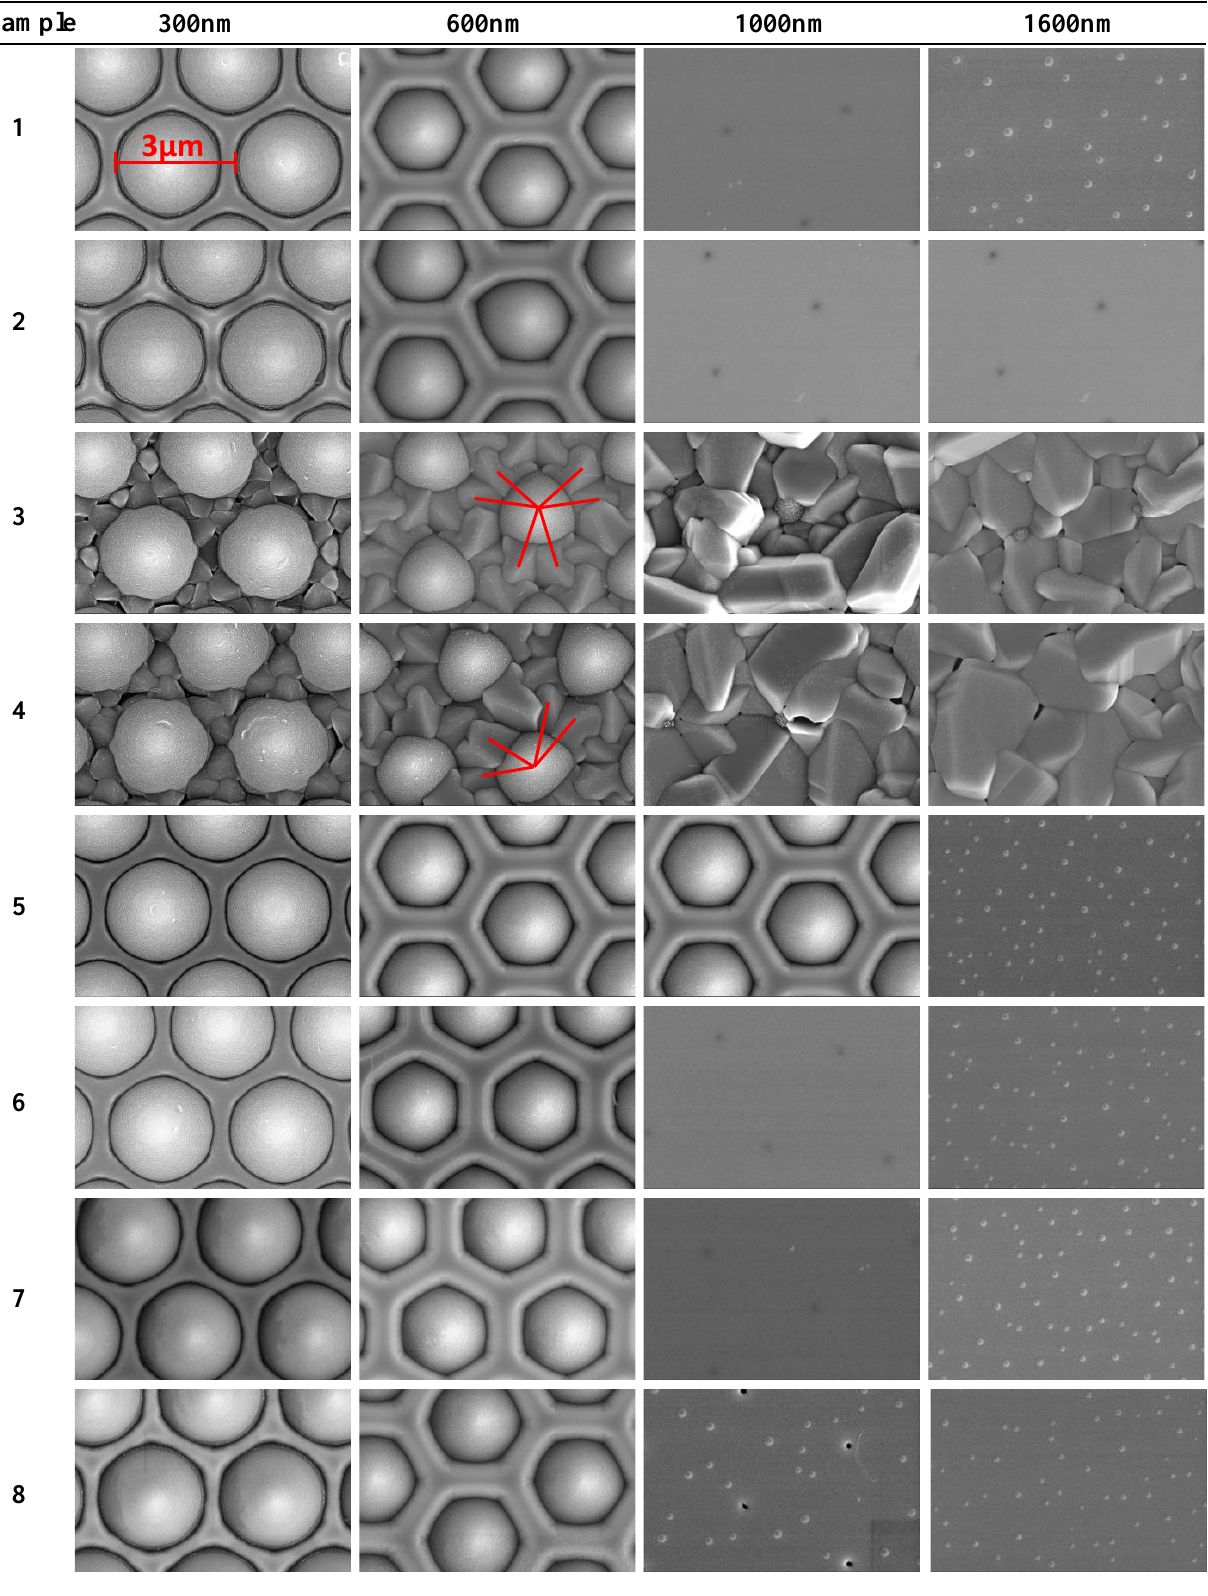
Figure 1. The SEM images with the magnification of 20 k. The numbers of samples match those in Table 1. All the images use the same length scale shown in the 300 nm of sample 1. The short red lines signal the growth directions of GaN on the sides of SiO 2 patterns when the AC power is too